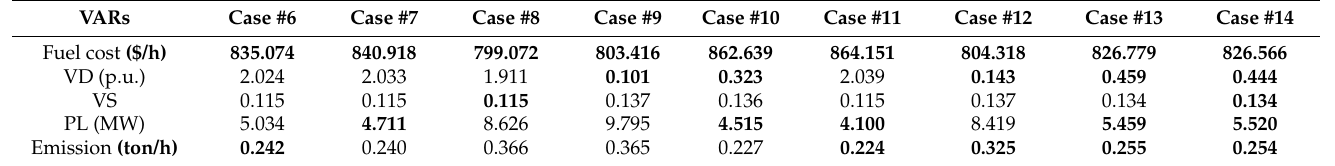
Table 4. Optimal power flow solution for IEEE-30 bus system using the TFWO algorithm for Cases 6–14.